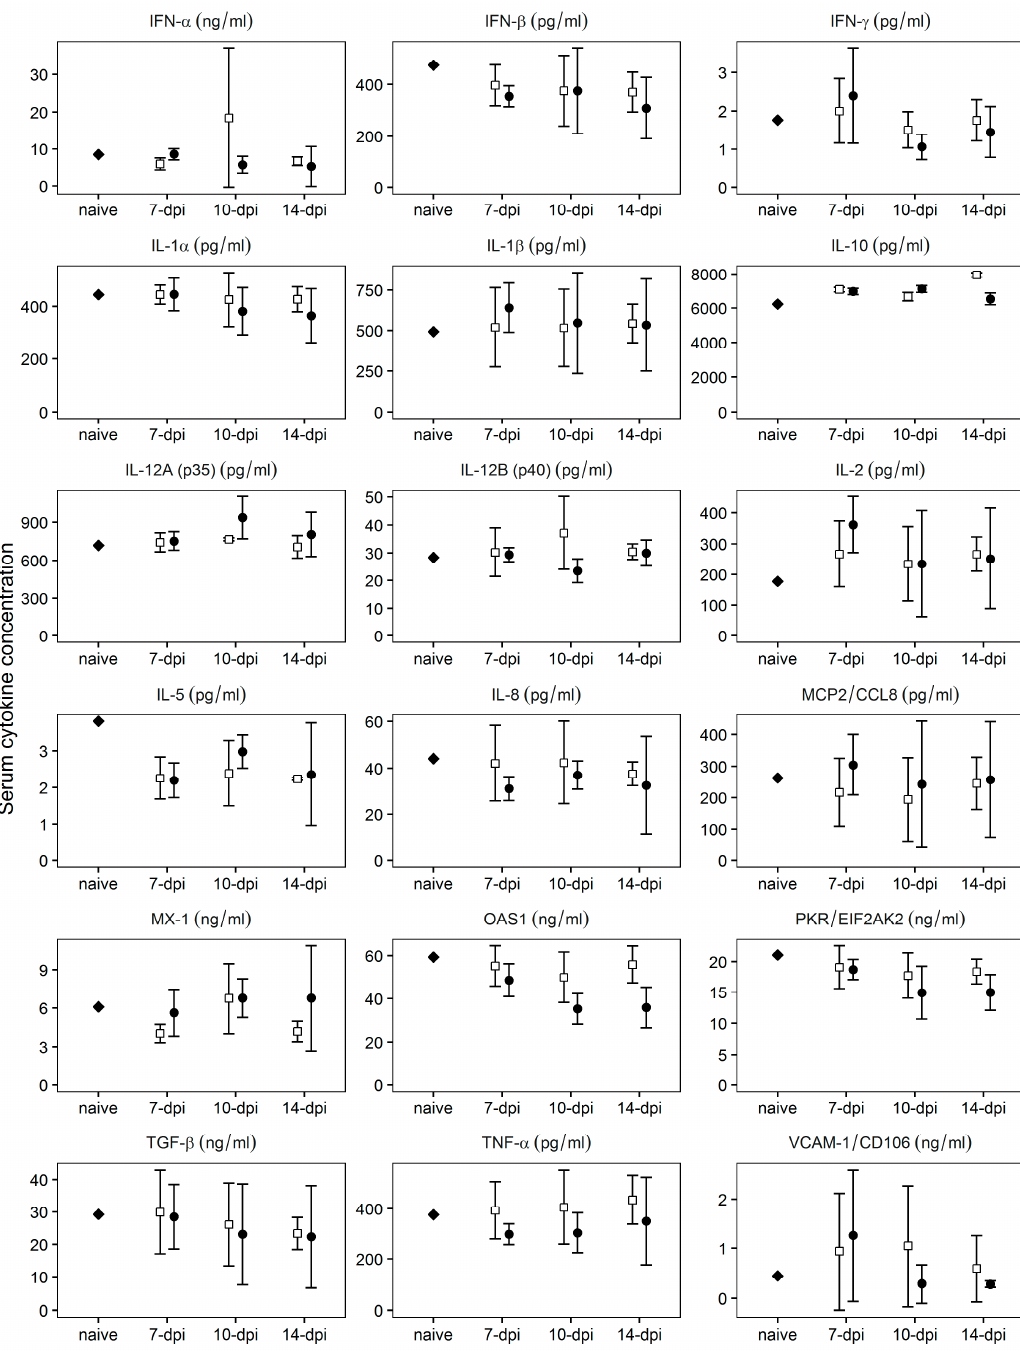
Figure 6. Evaluation of the systemic levels of different host cytokines at the time of challenge in swine infected with Pret4 ∆ 9GL virus. Average and 95% confidence intervals of 15, 10, and 15 animals from groups challenged at 7, 10, and 14 days post Pret4 ∆ 9GL infection are presented. Values are expressed as concentration per mL of serum determined as described in material and methods. IFN, interferon; IL, interleukin; MCP2, monocytes chemoattractant protein 2; OAS1, 5 ʹ‐ oligoadenylate synthetase 1; PKR, protein kinase R; TGF, transforming growth factor; TNF, tumor necrosis factor; VCAM-1, vascular cell adhesion molecule